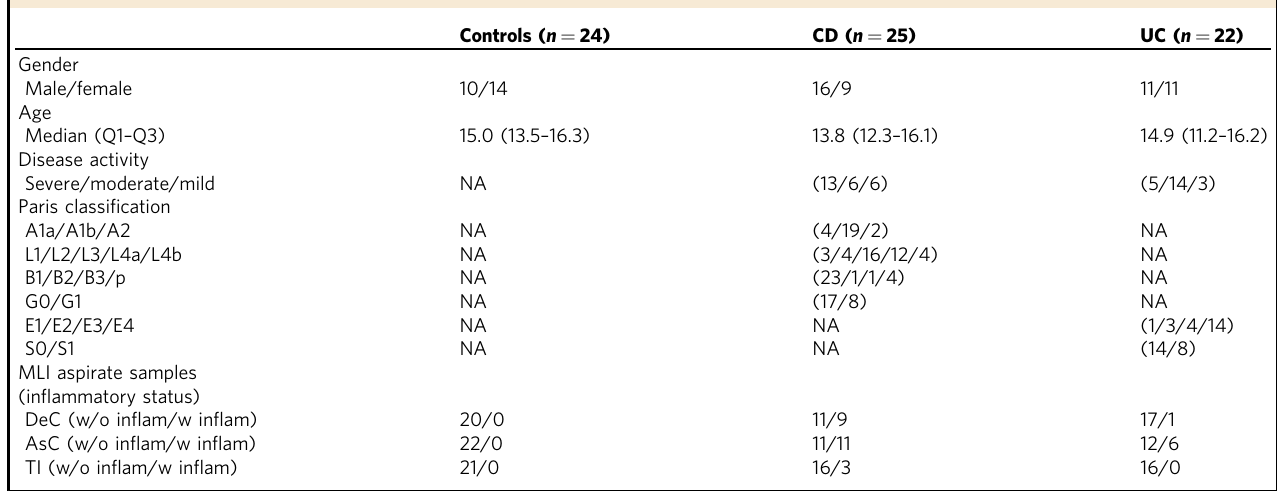
Table 1 Patient characteristics of treatment-naïve pediatric IBD cohort